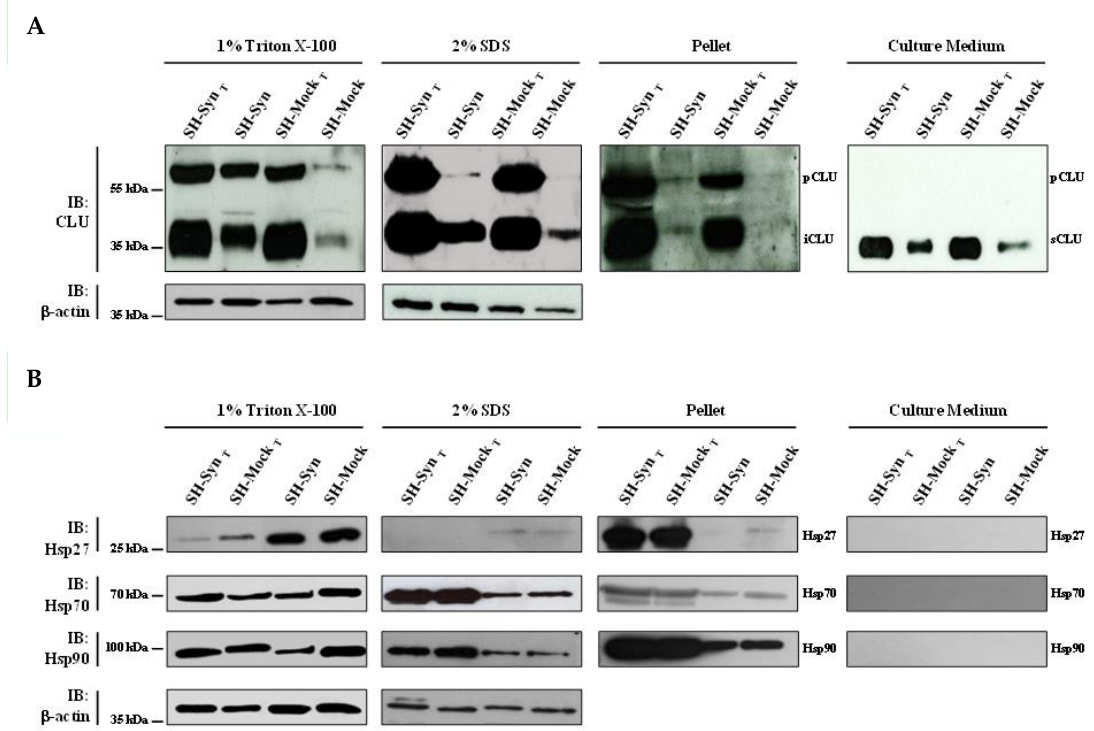
Figure 5. Chaperone protein level in SH-Syn and SH-Syn T . Detection of ( A ) CLU and ( B ) Hsp27, Hsp70, and Hsp90 in the 1% Triton X-100 soluble fraction, in the 2% SDS soluble fraction, in the pellet fraction, and in the culture media of SH-Syn, SH-Syn T , SH-Mock, and SH-Mock T . Blots are representative of experiments repeated three times. β -actin was used as the loading control.